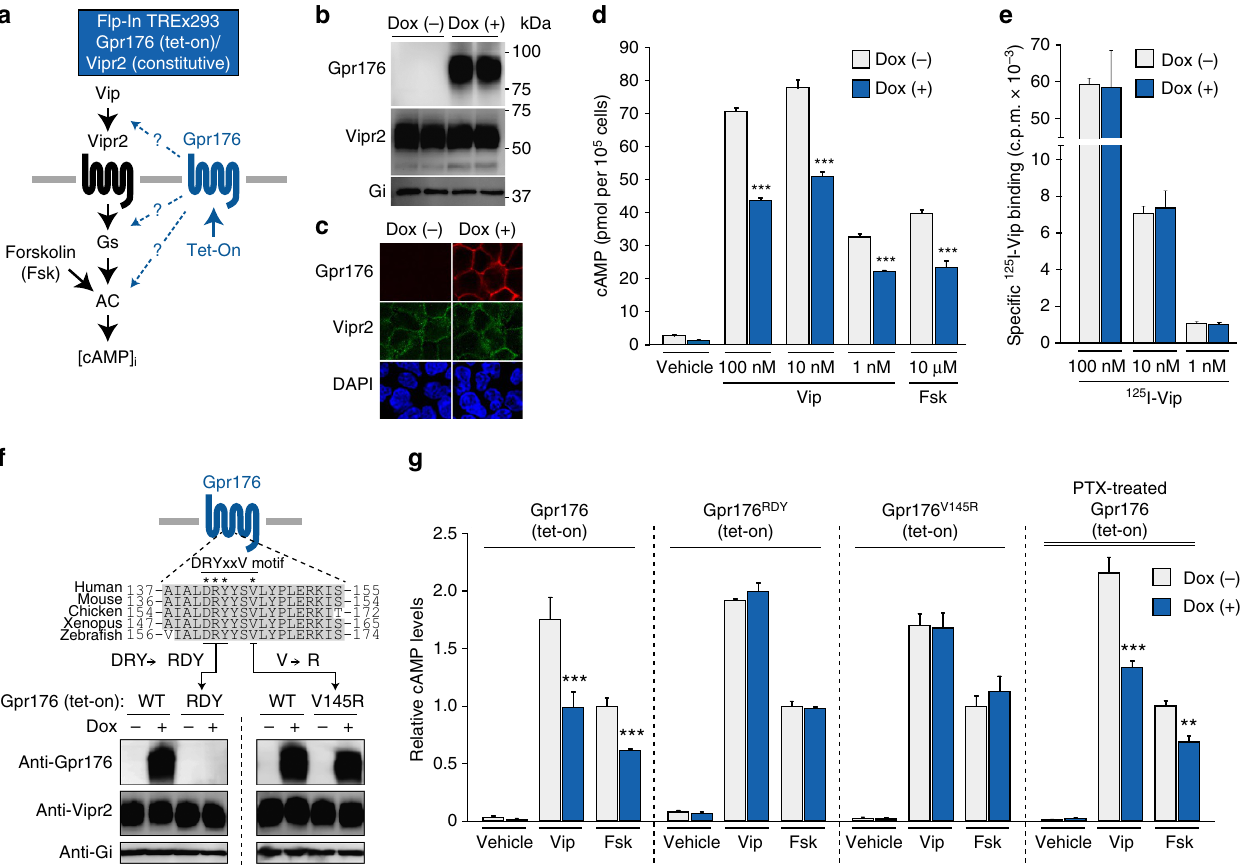
Figure 3 | Gpr176 basal activity inhibits Vip–Vipr2–cAMP signalling. ( a ) Experimental schemes based on Flp-In TREx293-Gpr176(tet-on)/Vipr2 cells. ( b ) Immunoblots of Gpr176 and Vipr2 with cell membrane fractions of Flp-In TREx293-Gpr176(tet-on)/Vipr2 cells. Cells were treated with either 1 m gml (cid:2) 1 Dox or control vehicle for 24h. Gi was used as a loading control. ( c ) Confocal images of representative dual-label immunofluorescent staining of Gpr176 and Vipr2 in Dox-treated or non-treated Flp-In TREx293-Gpr176(tet-on)/Vipr2 cells. ( d ) Antagonistic basal activity of Gpr176 on Vip- and forskolin (Fsk)-stimulated cAMP accumulation in Flp-In TREx293-Gpr176(tet-on)/Vipr2 cells. Cells of the same batch were cultured in parallel with or without Dox for 24h then resuspended in 0.5mM IBMX (non-selective phosphodiesterase inhibitor)-containing assay buffer for 1h and stimulated with Vip or Fsk for 15min. Individual treatments were run in each experiment in triplicate. cAMP levels were determined by enzyme immunoassays. Values are expressed as mean ± s.e.m. per 1 (cid:3) 10 5 cells. *** P o 0.001 in comparison with the control stimulated group. ( e ) Unaltered, dose-dependent [ 125 I]-Vip binding activities of Dox-treated Flp-In TREx293-GPR176(tet-on)/Vipr2 cells. Values are means ± s.e.m. of four independent experiments. ( f ) Immunoblots of mutant cell lines expressing either Gpr176 RDY or Gpr176 V145R . Point mutations were introduced into the conserved DRYxxV motif residues on Gpr176 in Flp-In TREx293-Gpr176(tet-on)/Vipr2 cells. Western blotting was done as described in b . ( g ) Diminished basal activities of Gpr176 by DRYxxV motif mutation. Fsk-stimulated uninduced cells. *** P o 0.001, ** P o 0.01 in comparison with the control stimulated group. NATURE COMMUNICATIONS|7:10583|DOI: